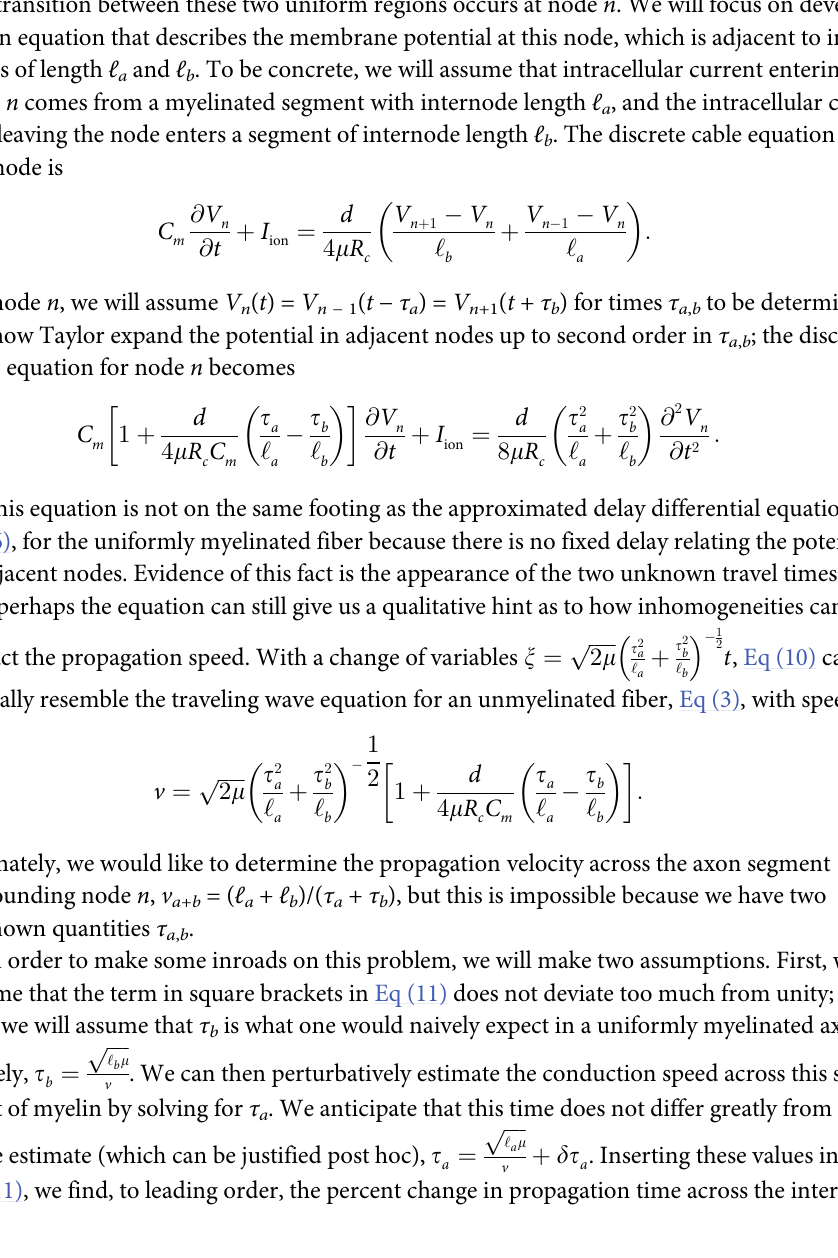
ffiffiffi p 2 (cid:25) 1 : 41 .